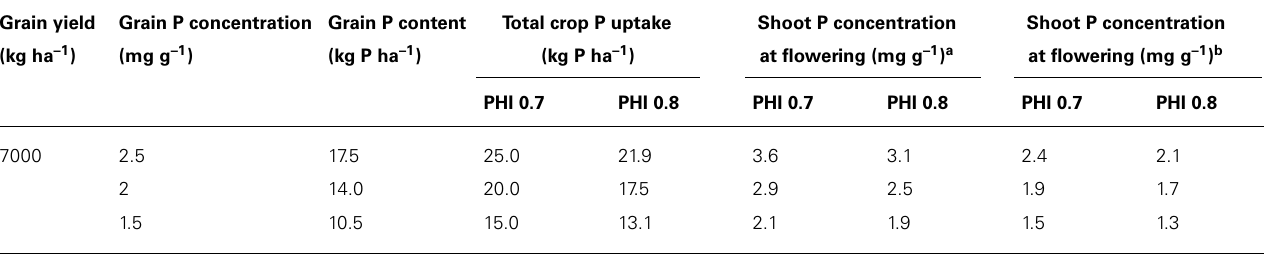
Table 1 | Simulated allowable changes in shoot P concentration at flowering with varying grain P concentrations or phosphorus harvest index